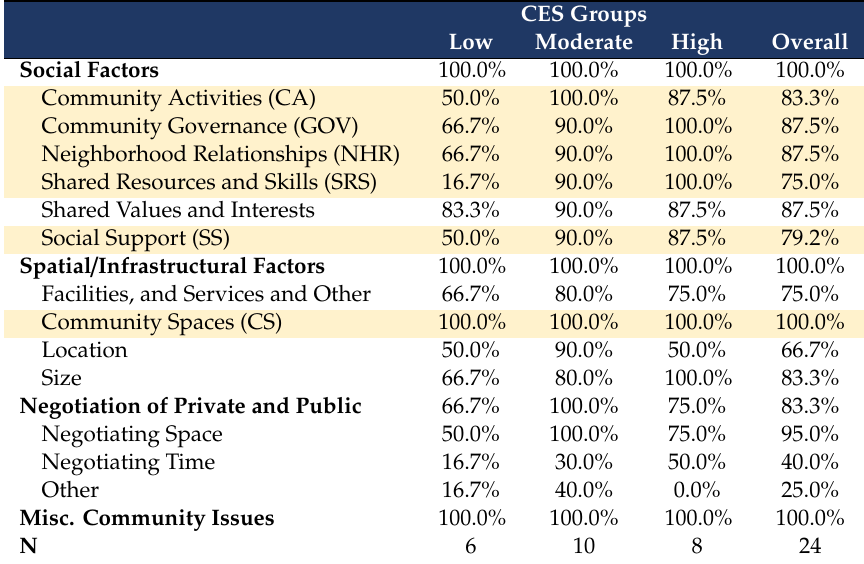
Note: Shaded Characteristics Constitute the Facets of the Community Engagement Style Index.